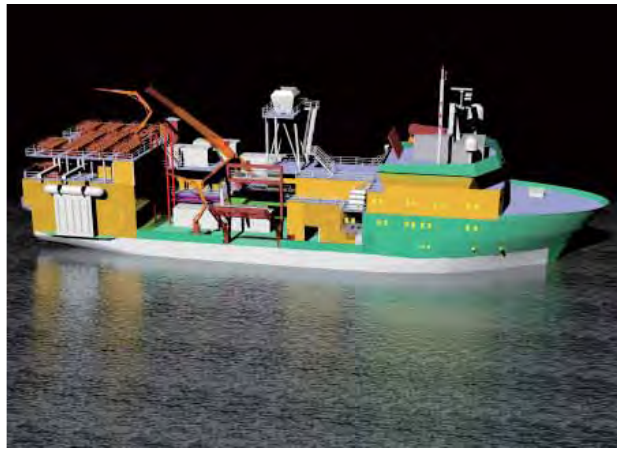
Figure 1. Model of the Marcus G. Langseth is a 235 ft, 2578 gross ton research vessel which is owned by the National Science Foundation and operated by Lamont-Doherty Earth Observatory of Columbia University. The Langseth replaces the Maurice Ewing, which has just ended a distinguished career (picture from http://www.ldeo.columbia.edu/res/fac/